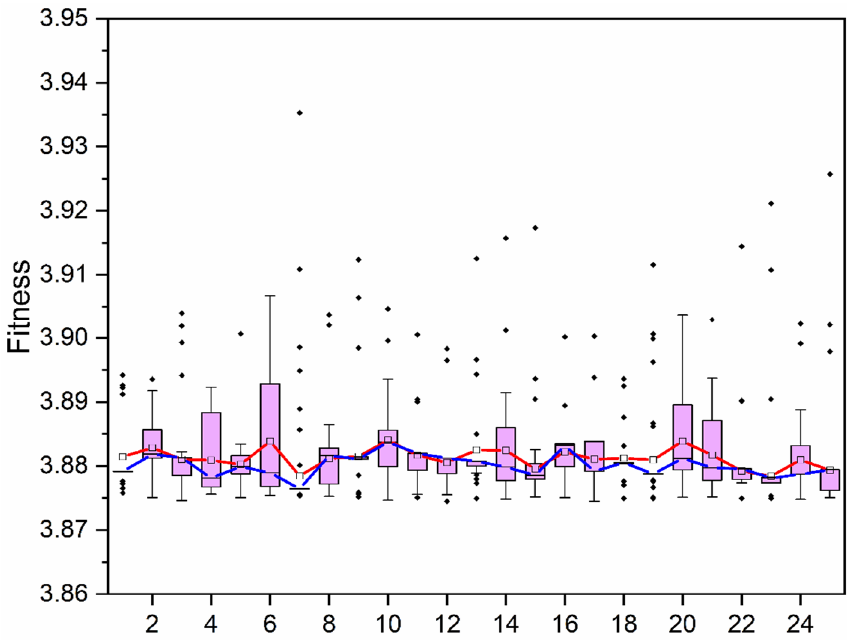
Figure 9. Box plot of 50,000 function evaluations of 25 independent GWO trials. The red line connects the mean of the box plots, while the blue line connects the medians.